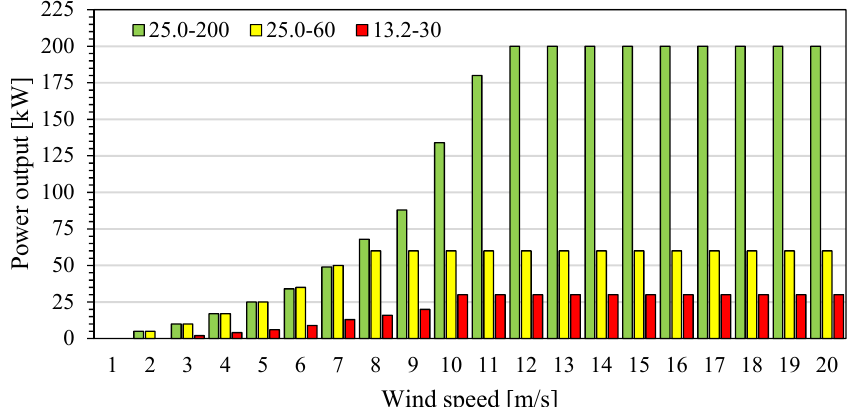
Figure A1. Power output of wind turbine as function of wind speed [57–59].